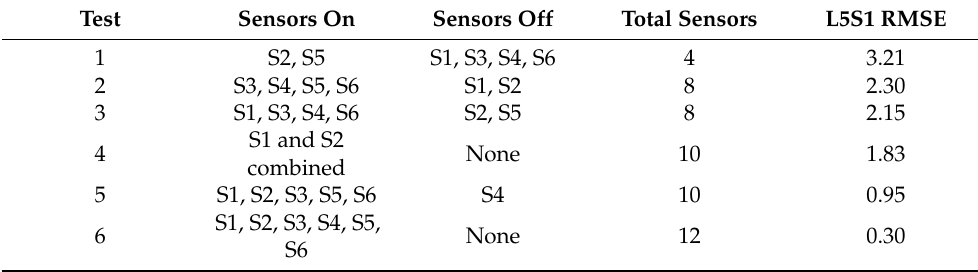
Table 3. Number of FSR sensors and their effect on